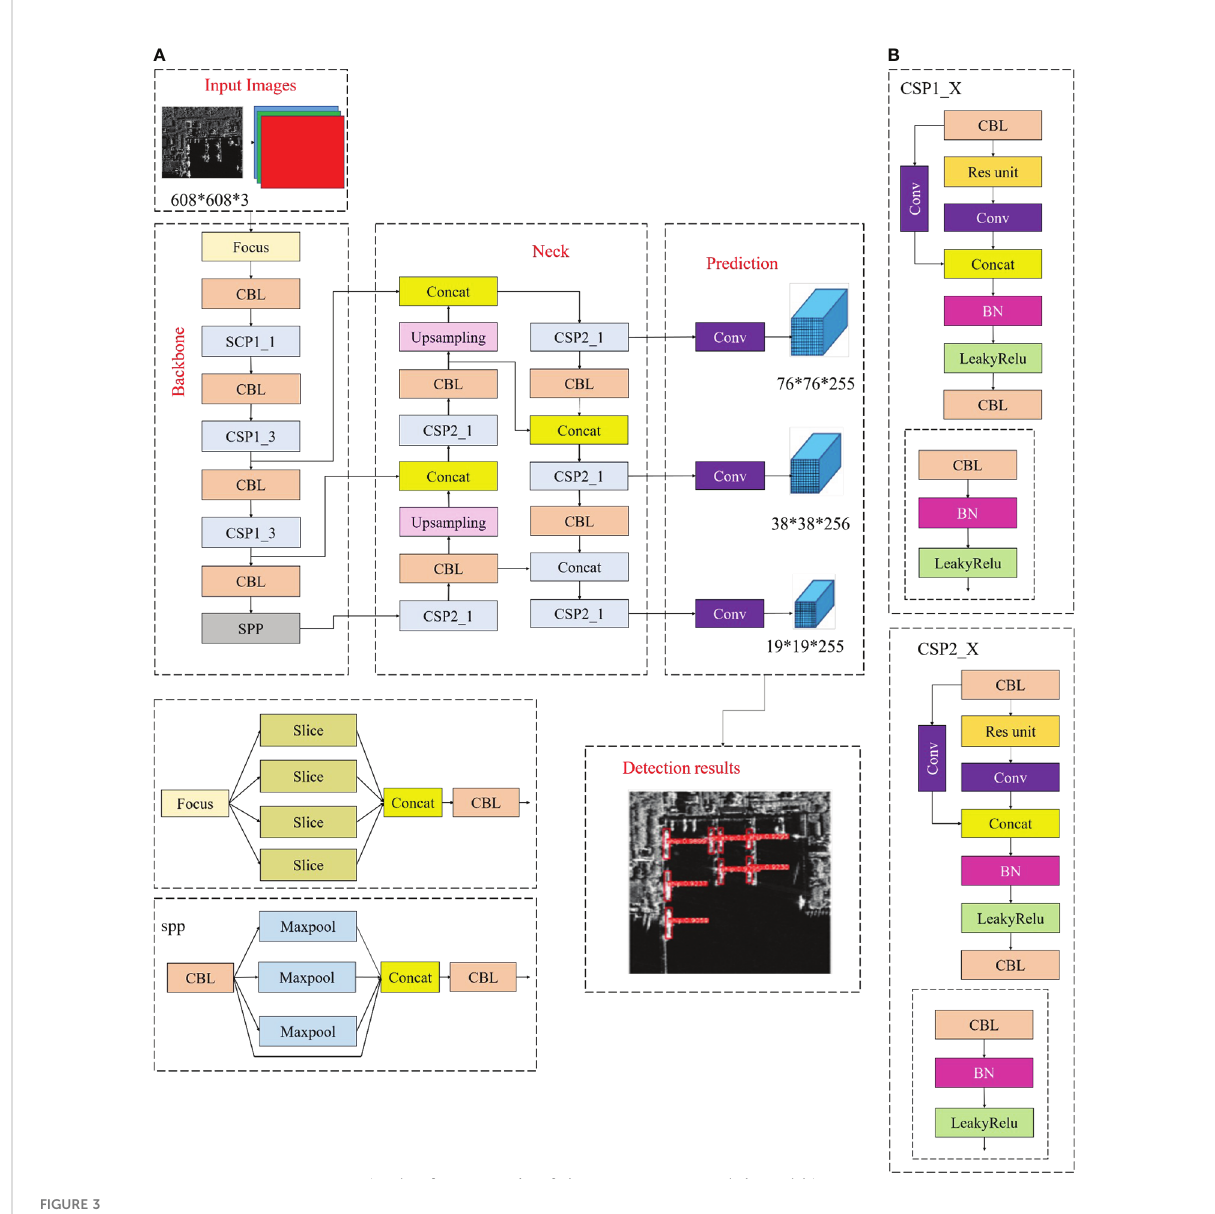
FIGURE 3 (A) The framework of the YOLOv5 Model, and (B) CSP